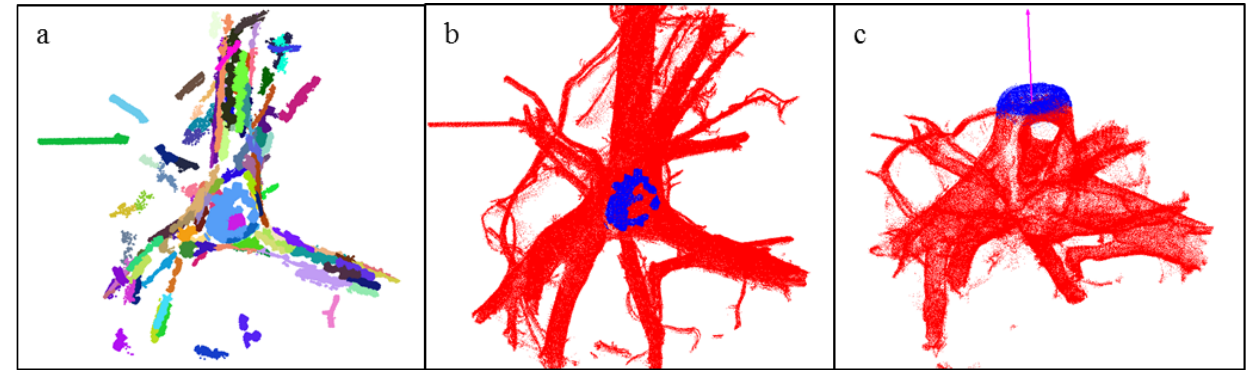
Figure 3. Determination of the cutting surface: ( a ) Segmentation of the stump portion into planar regions (only regions with at least five cover sets are shown); ( b ) Blue points show the initial cutting surface as defined by the selected large region; ( c ) The final cutting surface (blue) and the normal line